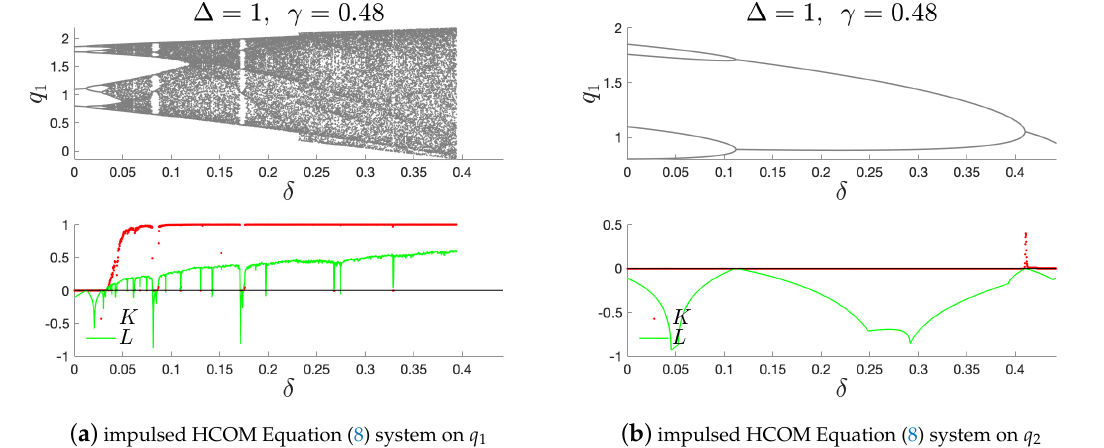
Figure 10. Impulsed HCOM Equation (2) system on q 1 ( a ) and q 2 ( b ): BD δ with ∆ = 1 and γ =